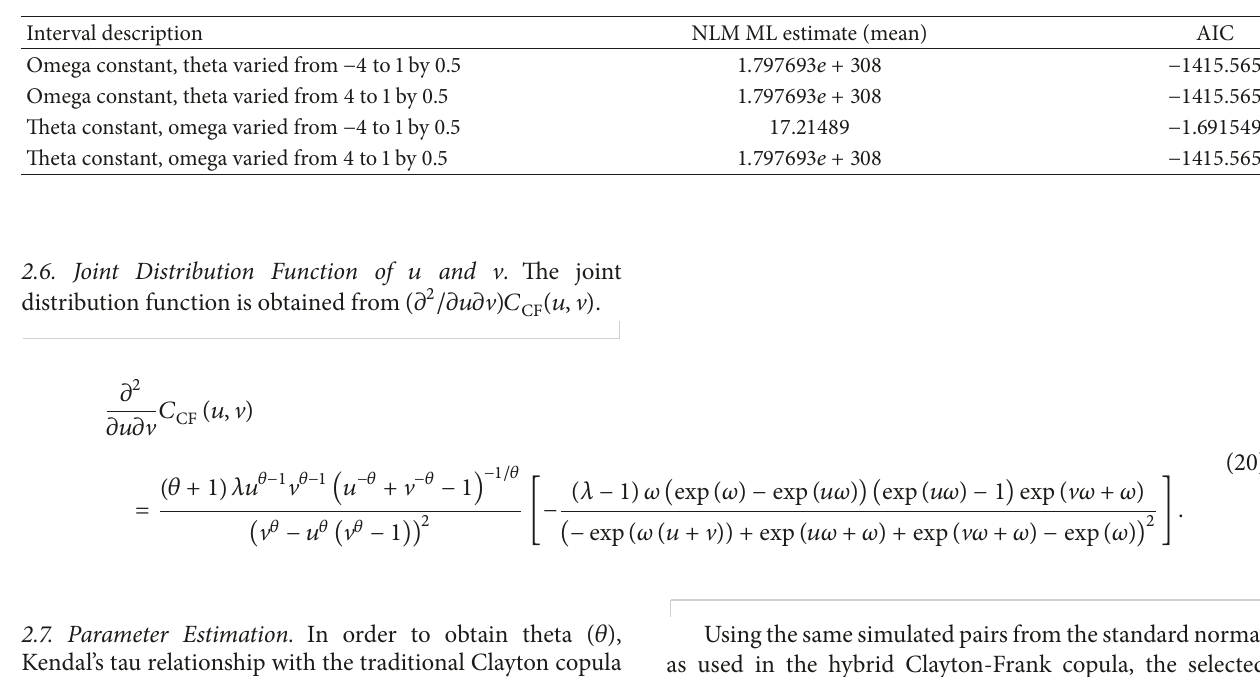
Table 2: Summary of results for lambda =